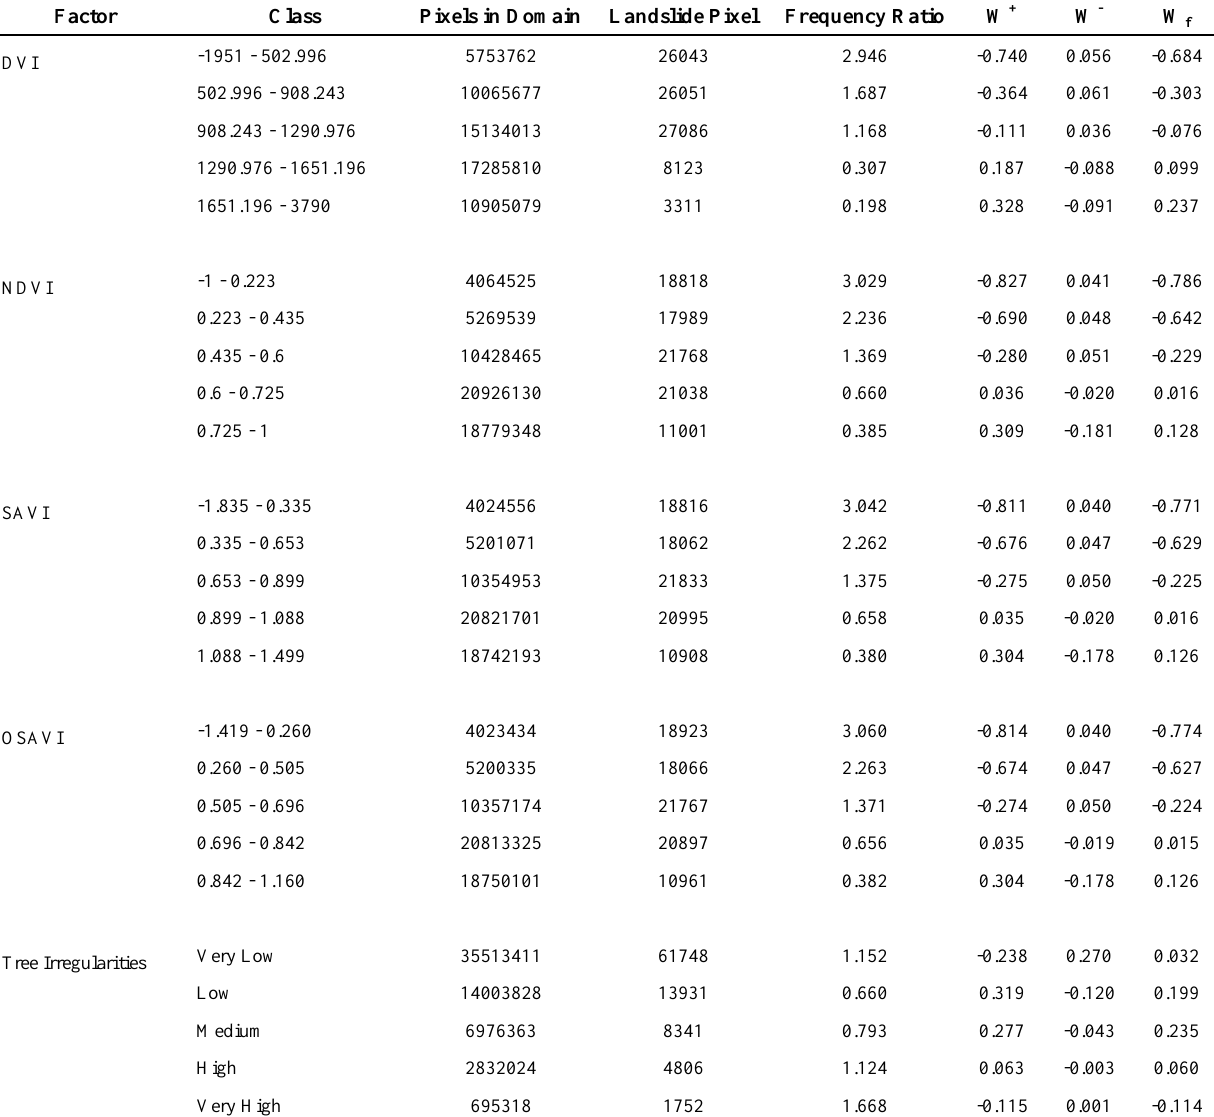
Table 2. Spatial relationship between each indicator and the landslides for the FR and WoE (dormant landslide) Factor